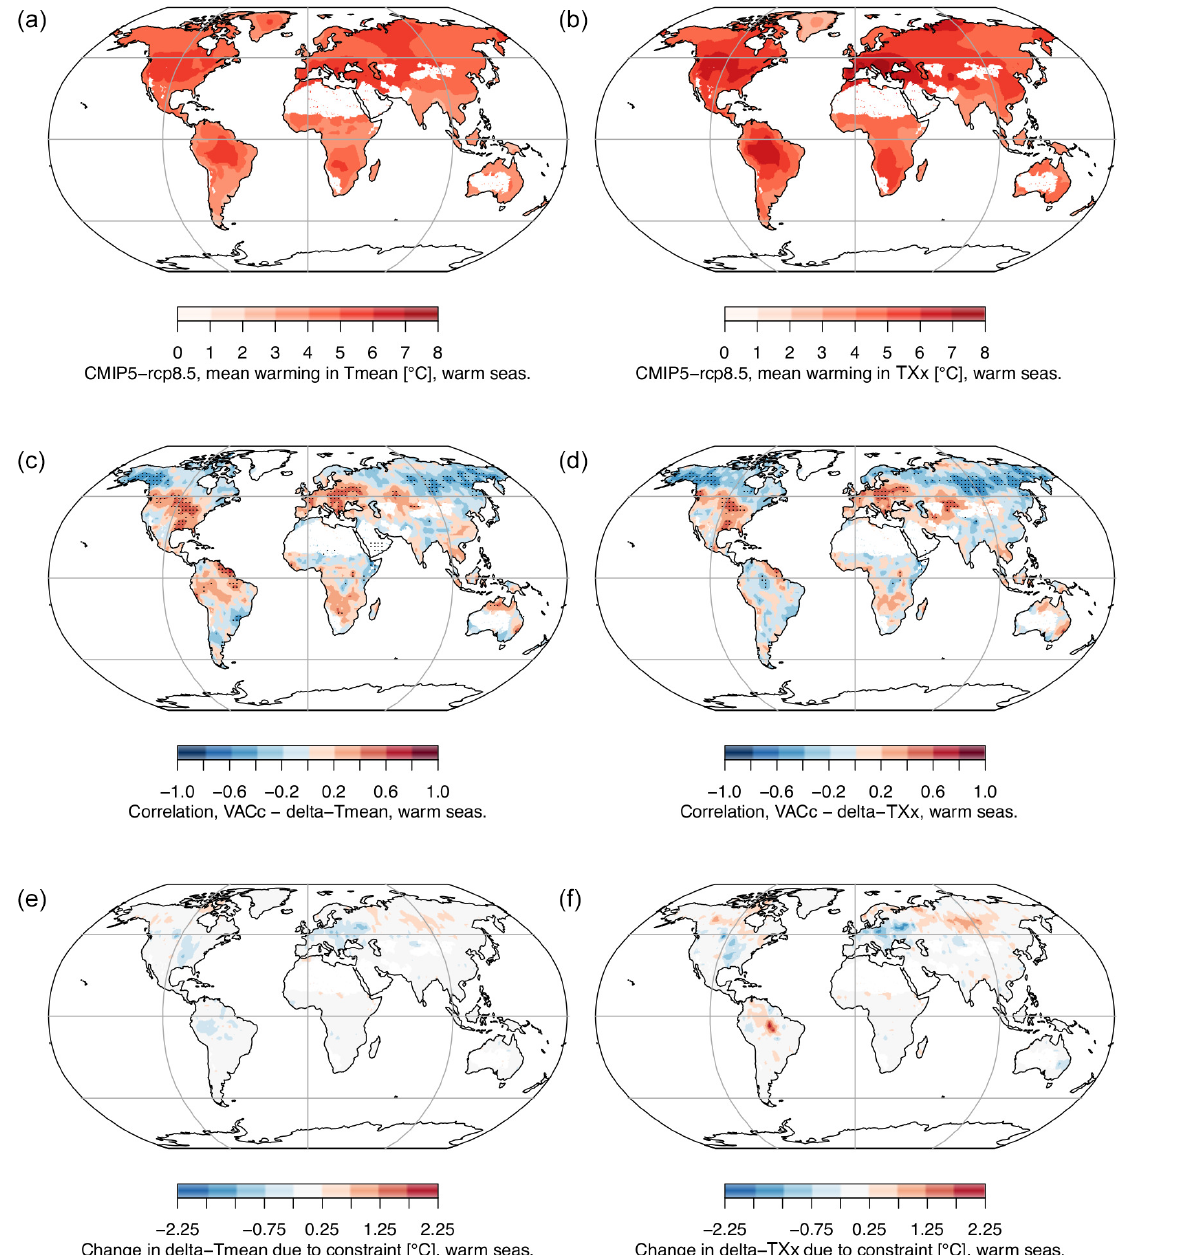
Figure 6. (a, b) Projected warming in warm season (a) mean temperature and (b) TXx across the CMIP5 ensemble (RCP8.5 scenario, 2071– 2100 relative to 1981–2010). (c, d) Correlation between VACc in the warm season and the projected warming in (c) mean temperature and (d) TXx. Stippling indicates significant correlations. (e, f) Relative change in (e) mean warming and (f) TXx warming due to the application of the land–atmosphere coupling constraint; warming defined as 2071–2100 relative to